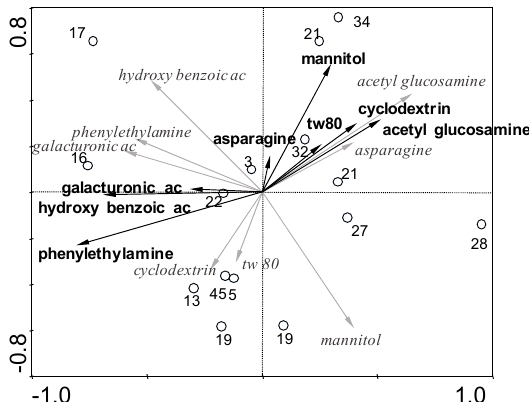
Figure 3. Redundancy analysis (RDA) diagram comparing SIR (black bold arrow) and Biolog (grey, thin arrow) data with the options “centering and standardization of sites” and “centering by a substrate” along a successional gradient of unreclaimed post-mining soils (circles and numbers indicate site